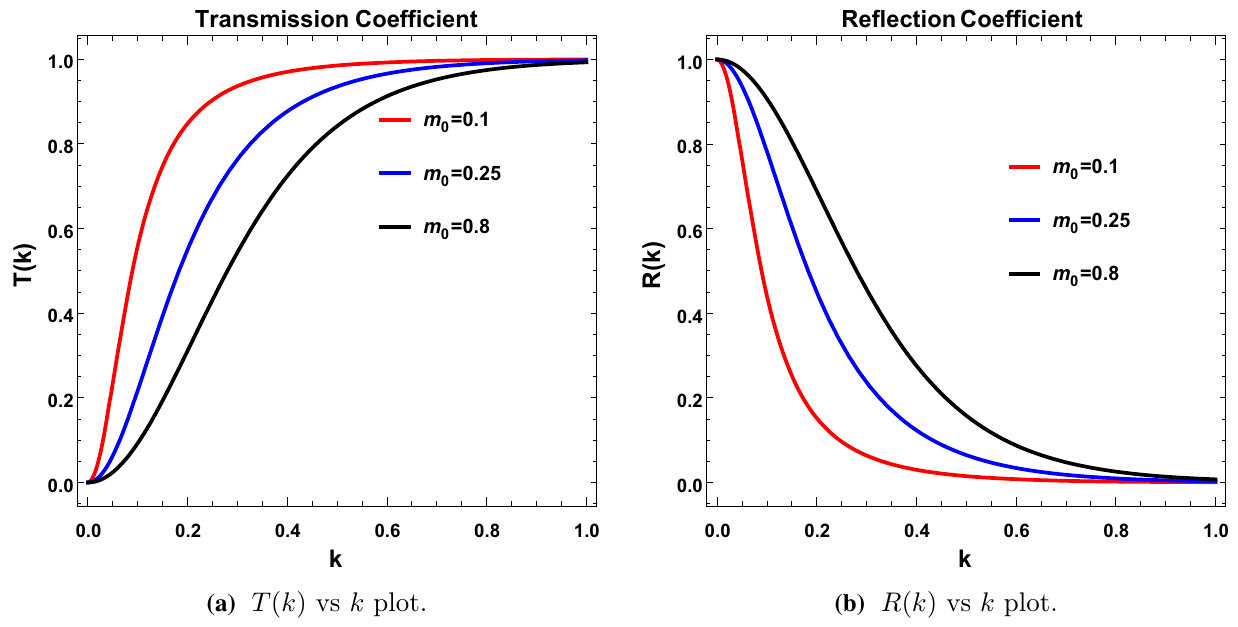
Fig. 12 Transmission and Reflection Coefficient for mass profile m 2 ( t ) = m 2